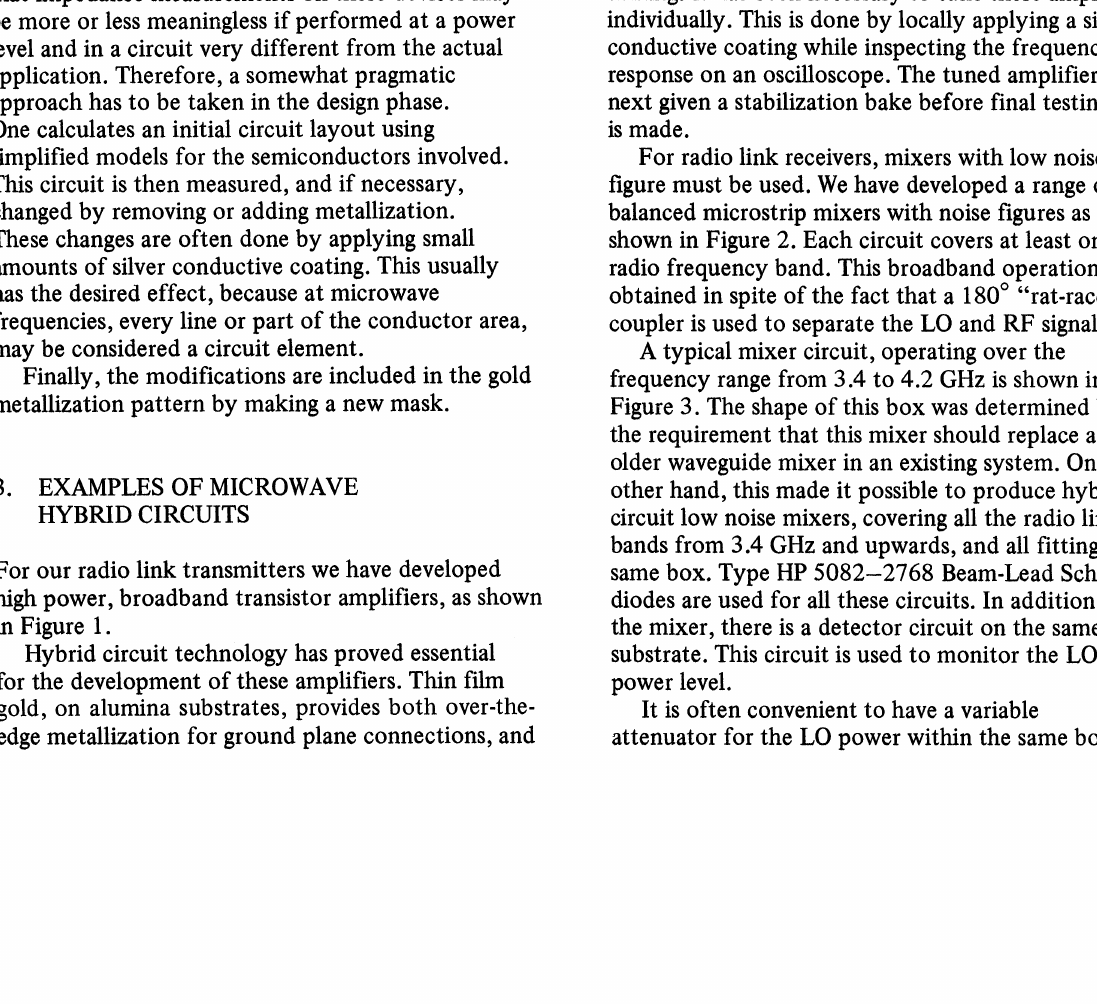
112 14 FREQUENCY (GHz) FIGURE 7 Attenuation in Microstrip lines with 50 ohms characteristic impedance. Different